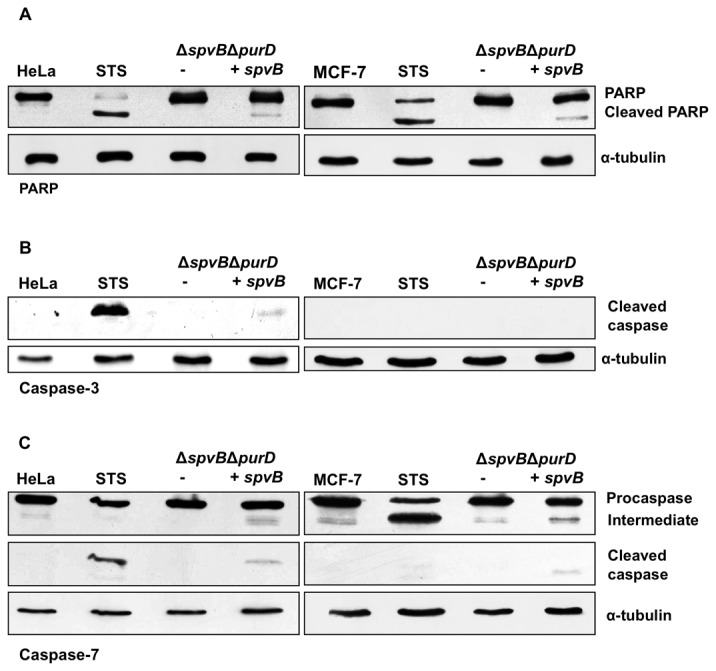
Apoptosis induction by overproduction of SpvB.